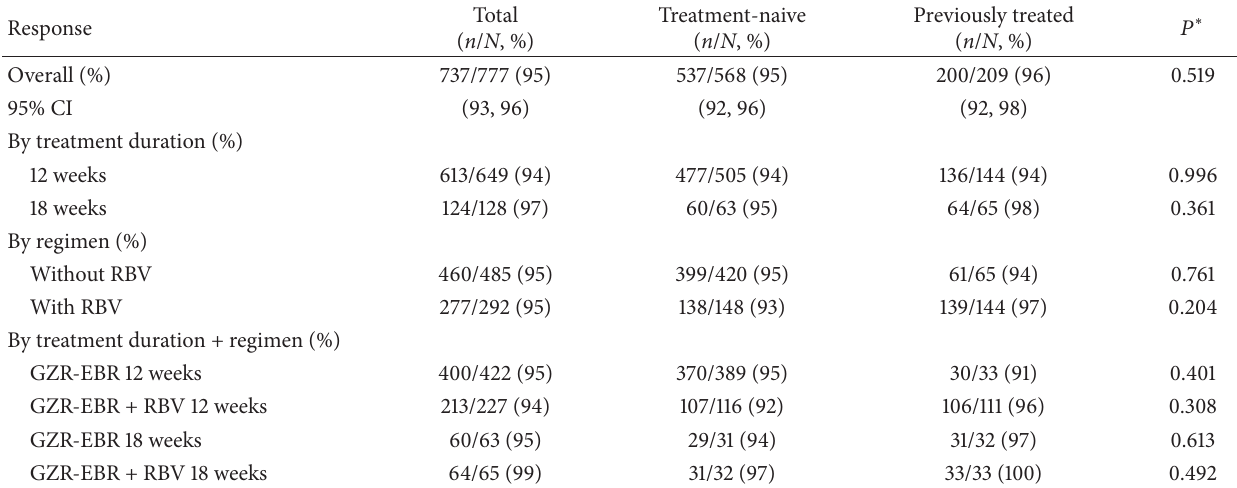
Table 2: SVR12 by baseline factors, treatment history, and